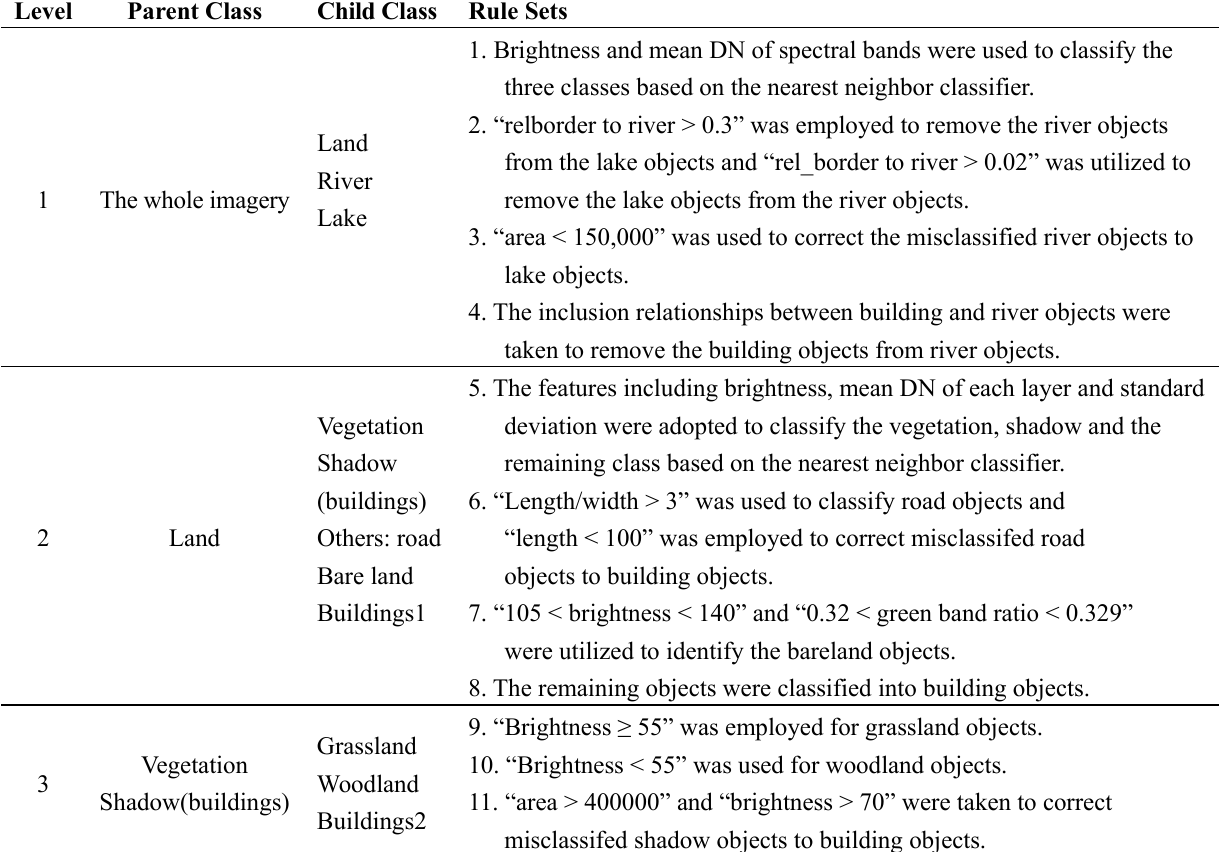
Table 2. Variables and rules used for GE imagery